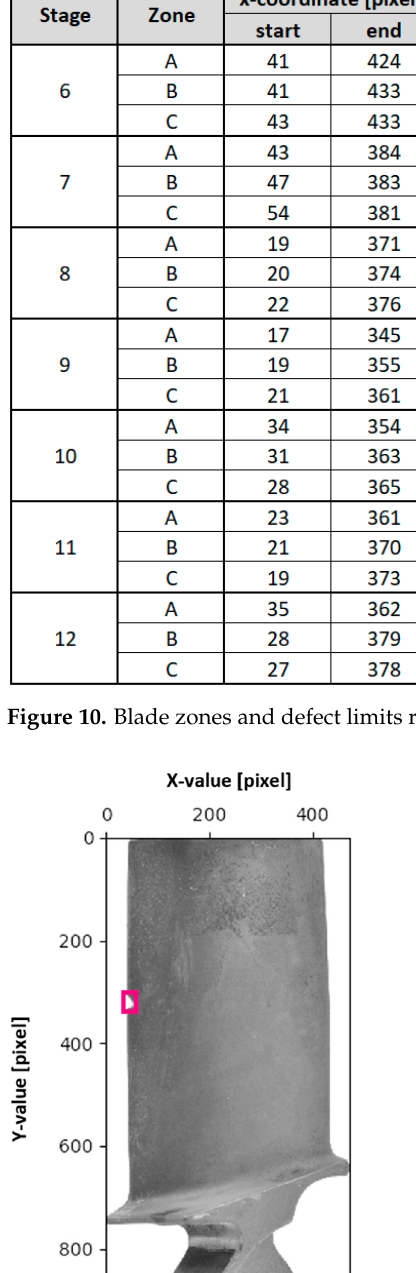
Figure 12. User interface of decision support tool (DST). The output file of the detection software contains the defect location, dimensions and shape descriptors (defect characteristics). However, not all of this information is needed for the DST and only the required data is extracted. This includes the defect location and the depth of the damage. The x- and y- coordinates of the defect location are used to determine in which blade zone the defect is located. This is important as each zone has different limits in terms of allowed damage size. The detection software delivers a set of two x/y-coordinates that